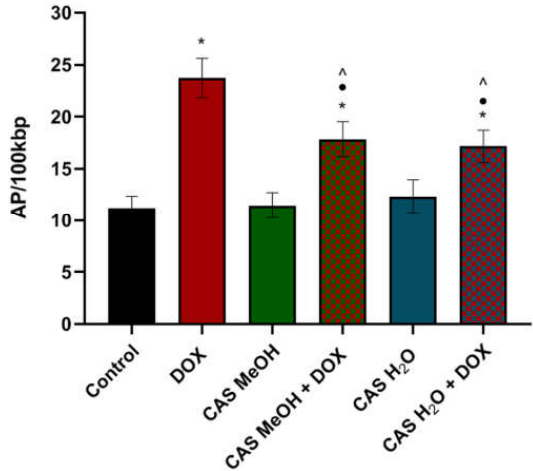
Figure 6. AP site levels in DNA of H9c2 cells. Cells were treated for 48 h with 2 µM of DOX and 125 µg/mL of CAS H 2 O or 125 µg/mL of CAS MeOH, or a combination (DOX + CAS MeOH/DOX +